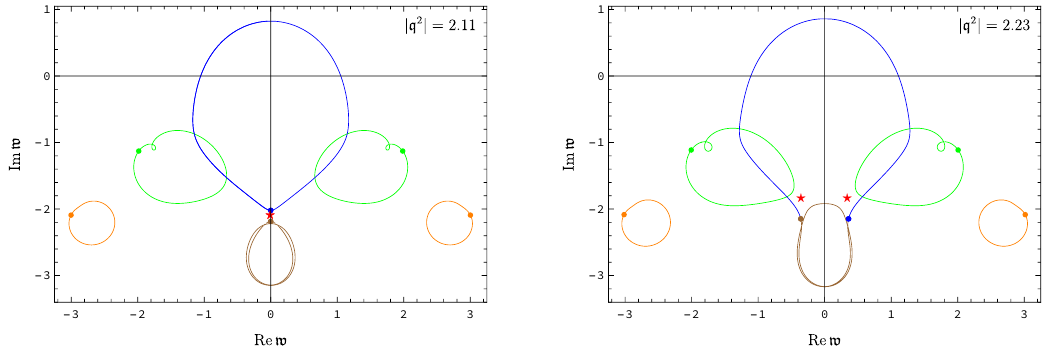
Figure 8 . Quasinormal spectrum in the shear channel at γ = 3 · 10 − 5 , computed non-perturbatively in γ . The radius of convergence is set by the level-crossing between the shear mode and the non- perturbative mode on the imaginary axis (left panel). This critical point coincides with the endpoint of the hydrodynamic regime discussed in ref. [16]. An example of critical points with a larger | q 2 | is shown in the right